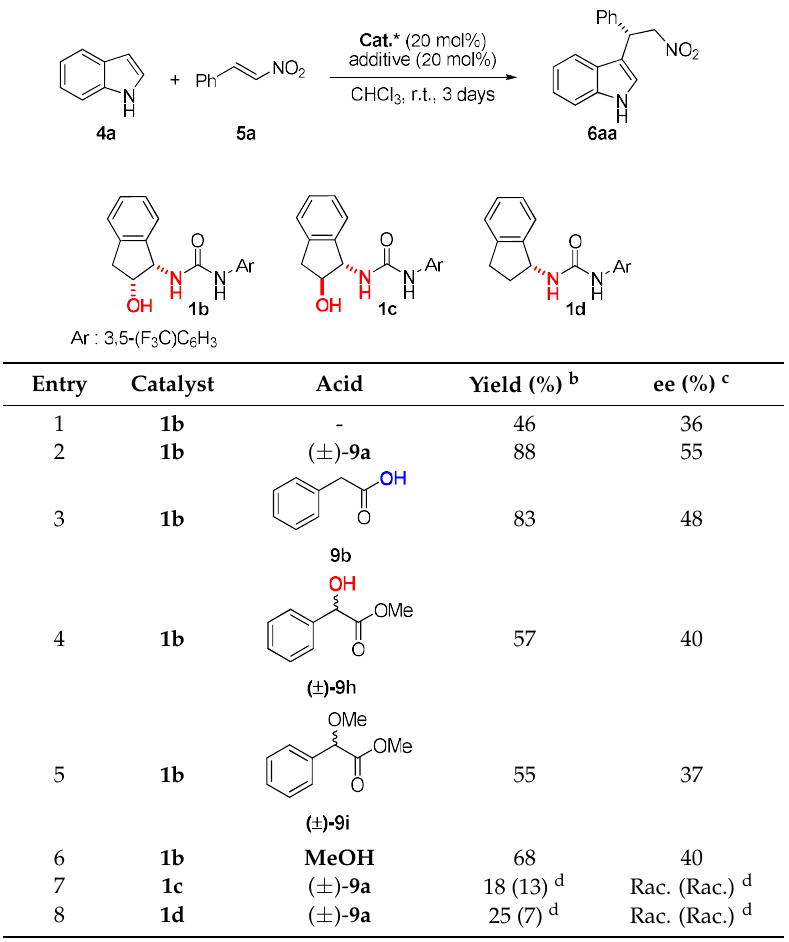
Table 3. Effect of the nature of the catalytic complex. a